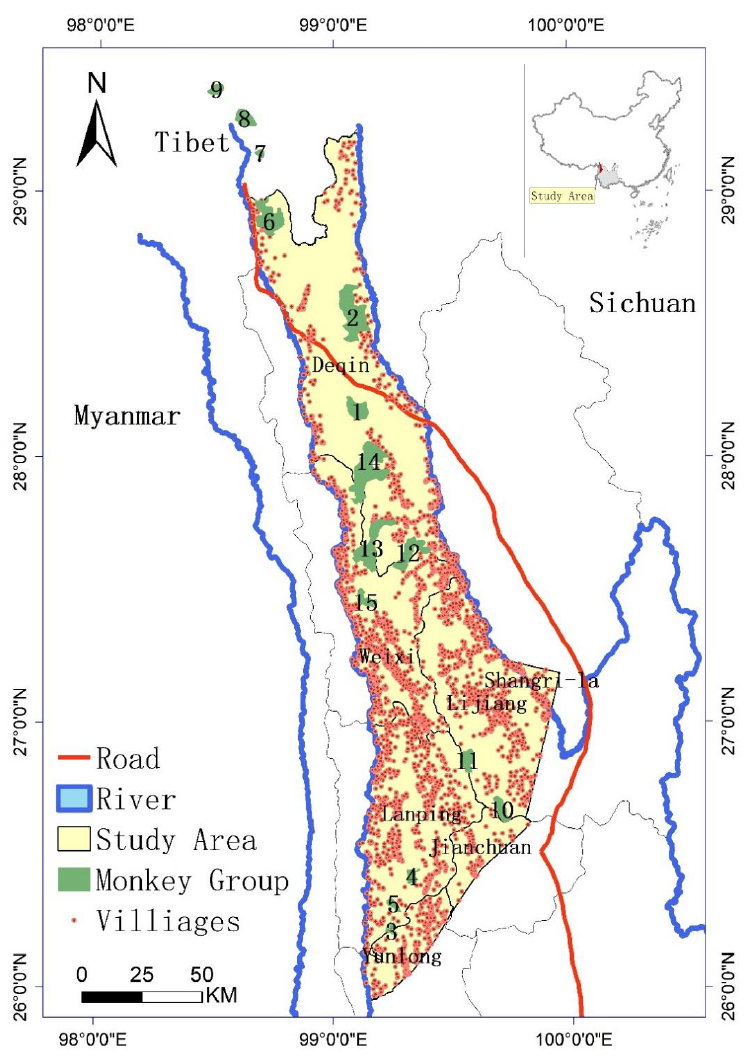
Figure 1. The study area and locations of monkey groups in Yunnan Province (China). The numbers labeling each green area represent the monkey group number